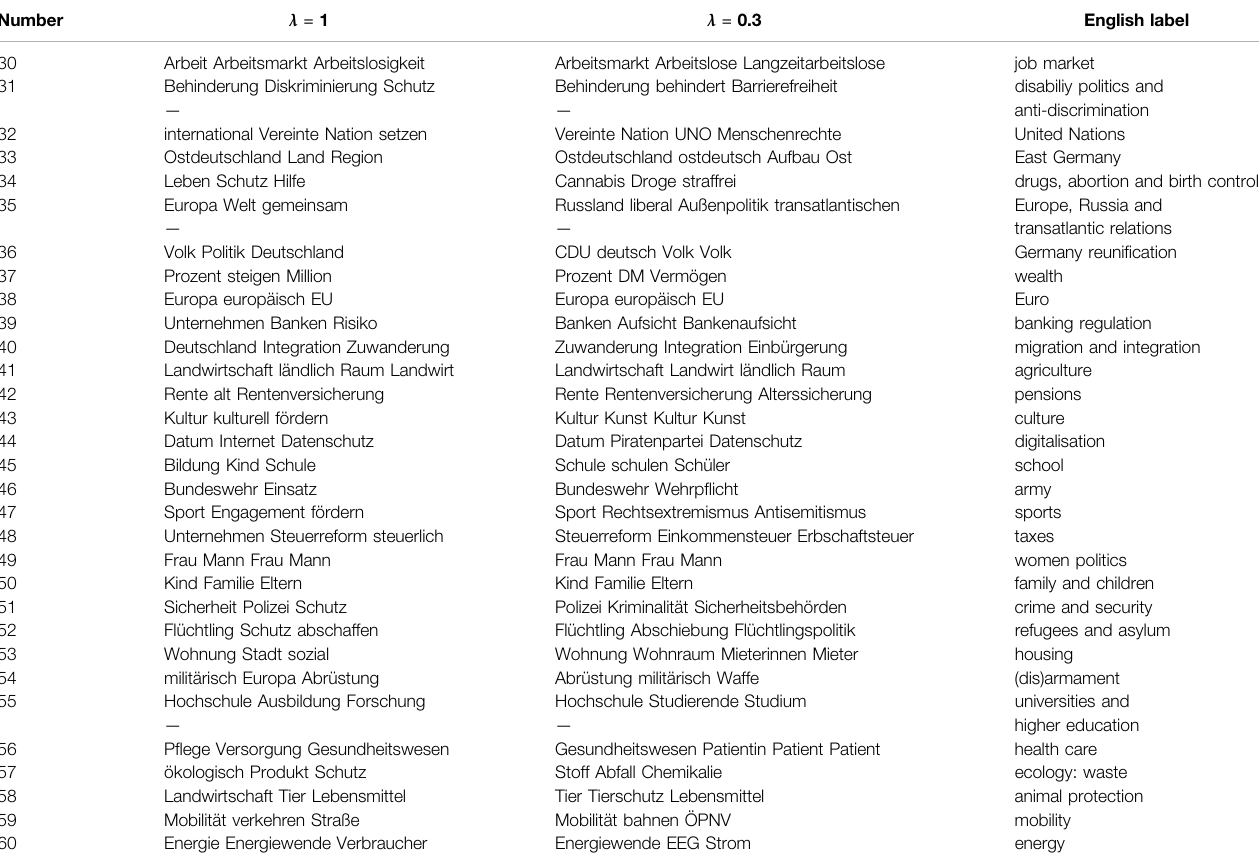
TABLE 2 | Last 30 topics of topic model A trained on German manifestos from 1949 to 2017.